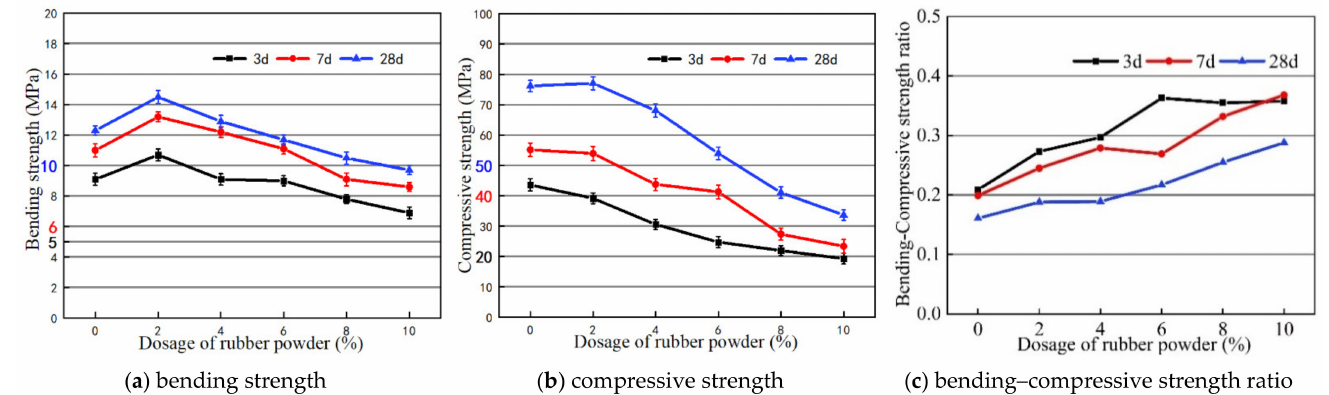
Figure 5. Mechanical strength of PPG with untreated 40 mesh of crumb rubber at different dosages.